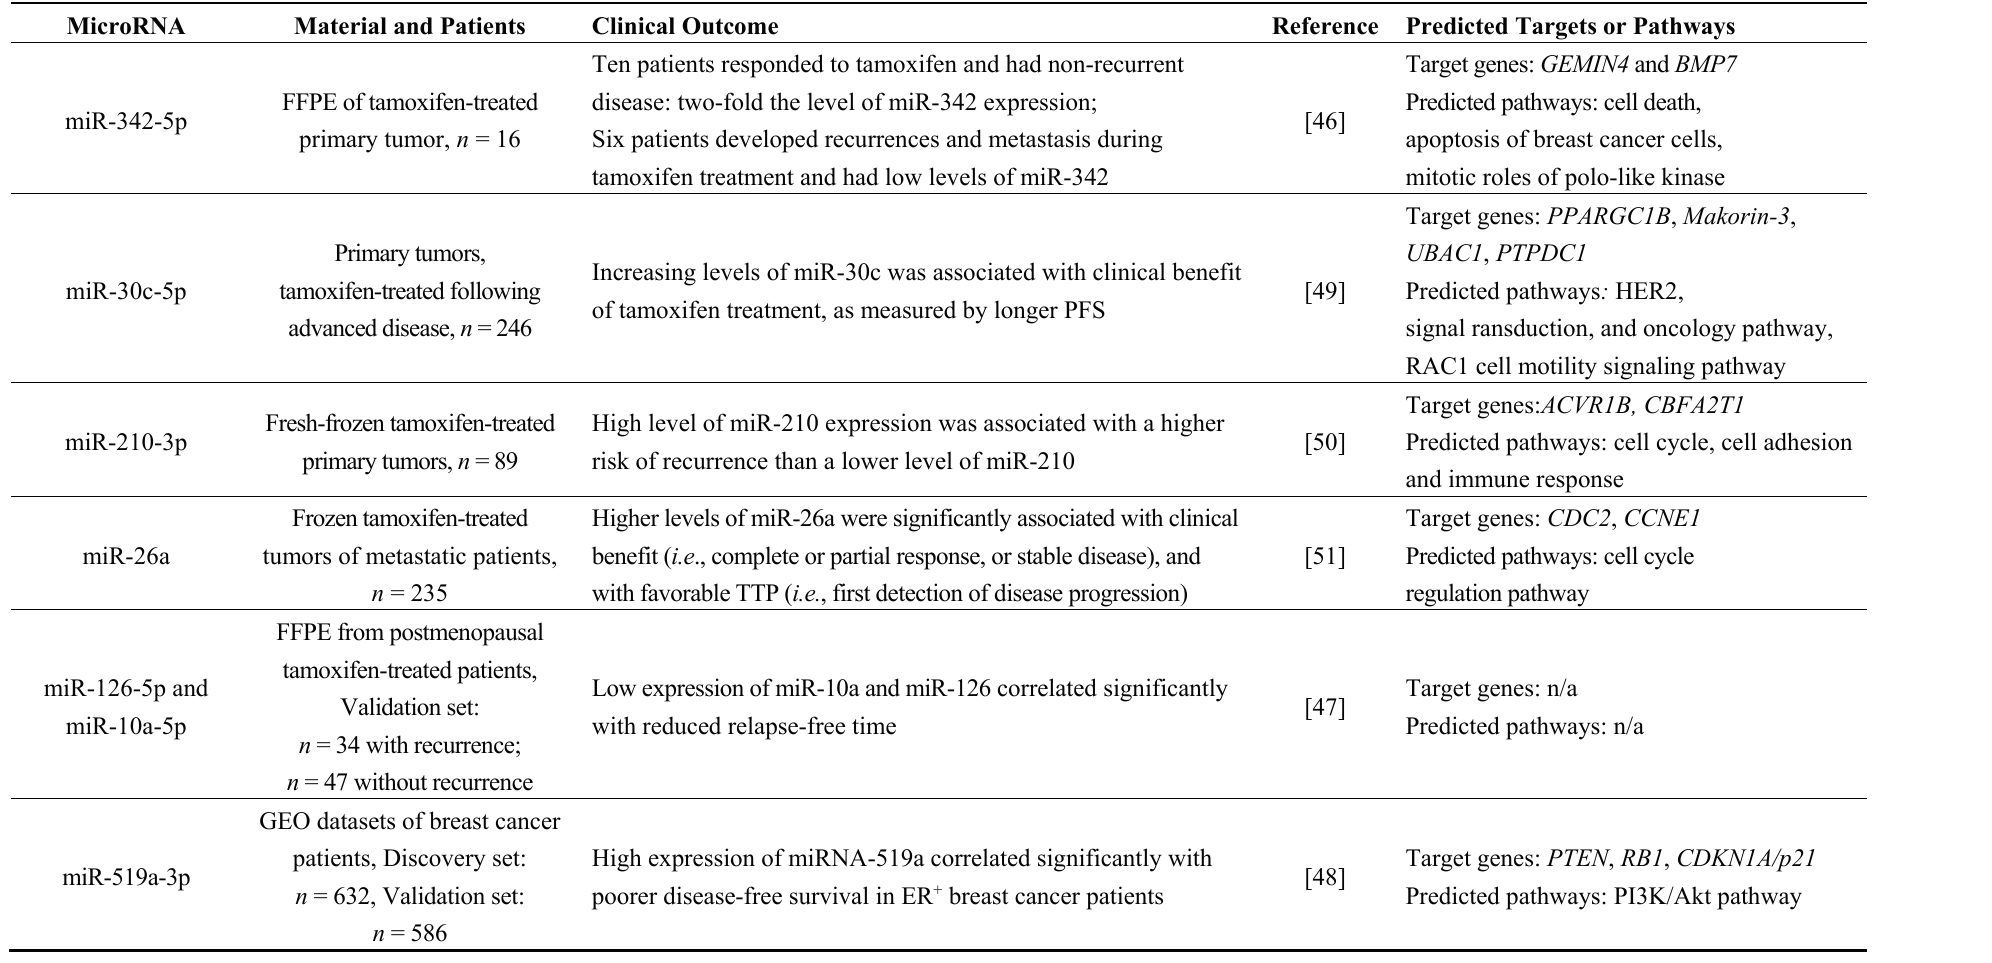
Table 1. Candidate microRNAs involved in tamoxifen